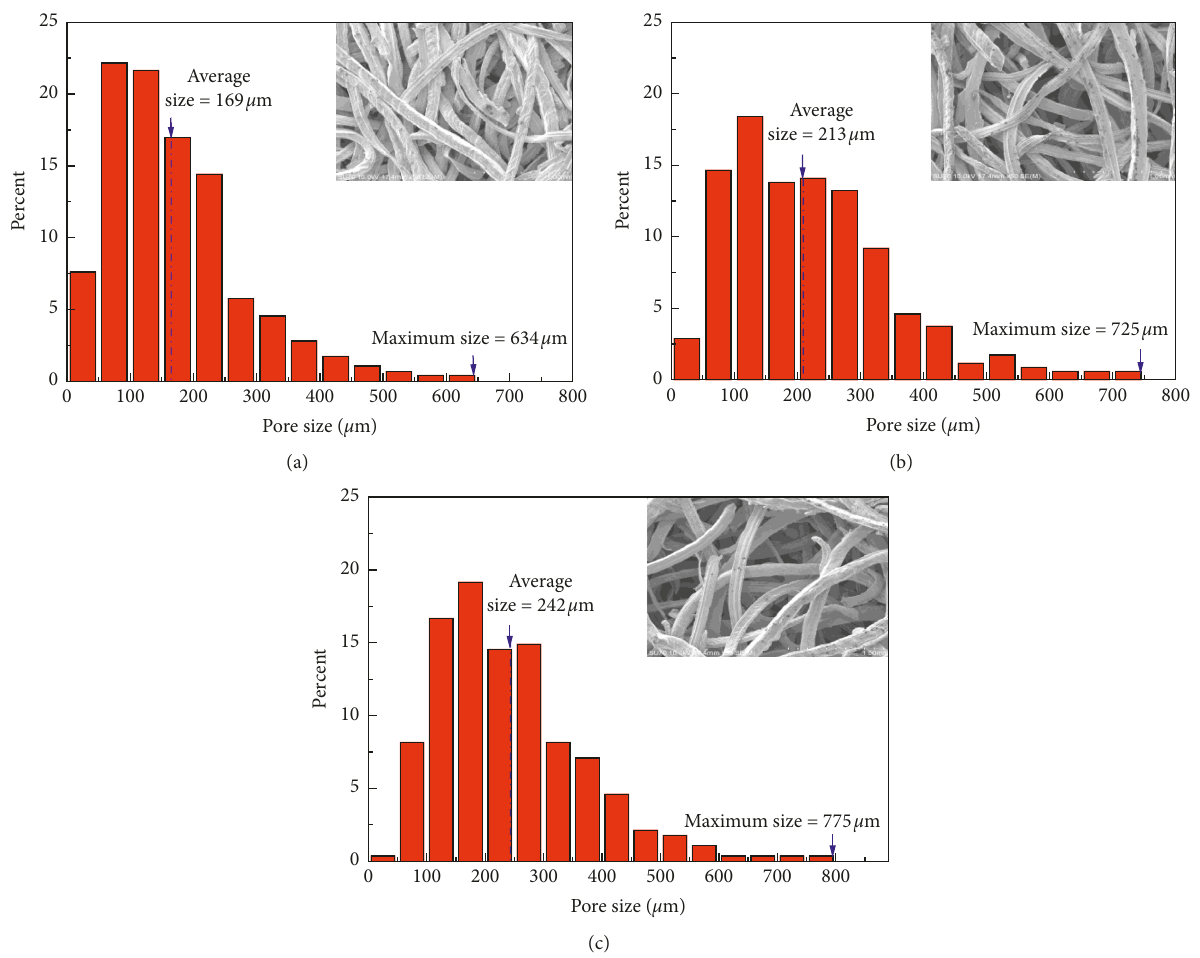
Figure 4: Surface morphology and pore-size distribution of PCFSSs with different porosities: (a) ε